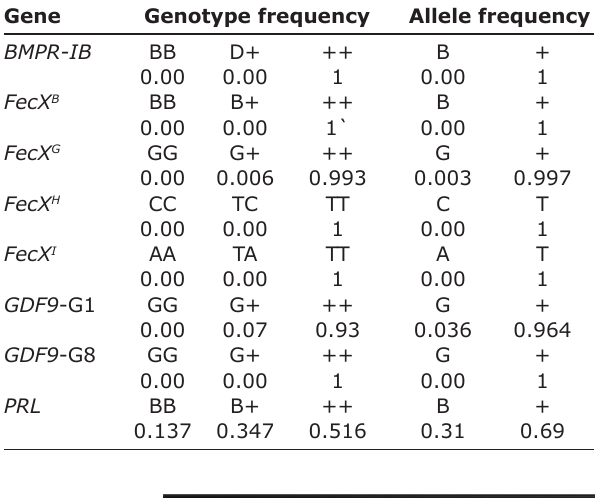
Table-2: Allele and genotype frequencies of the ovine BMPR-IB , BMP15 (FecX B , FecX G , FecX H , and FecX I ), GDF9 (G1-G8), and PRL genes in experimental population.